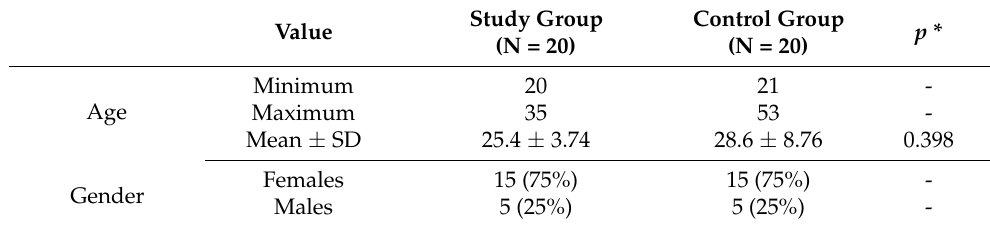
Table 1. Demographic characteristics of the two groups. Value